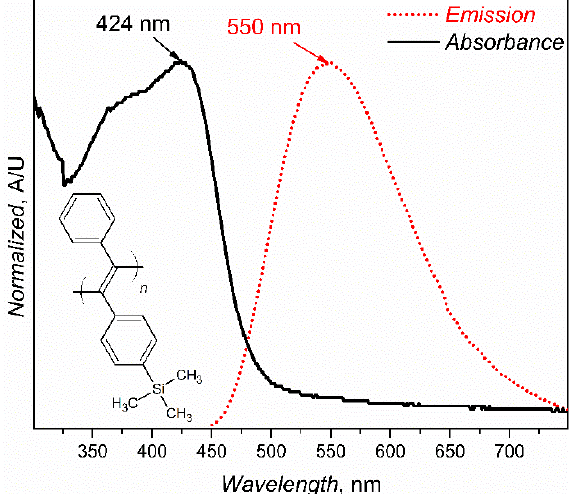
Figure 1. Normalised UV-Vis absorption spectrum and PL emission spectrum of PTMSDPA (pristine additive sample). The PL emission spectrum was recorded at an excitation wavelength λ ex = 424 nm in a thin film. The formula in the left lower corner of the graph shows PTMSDPA structure.